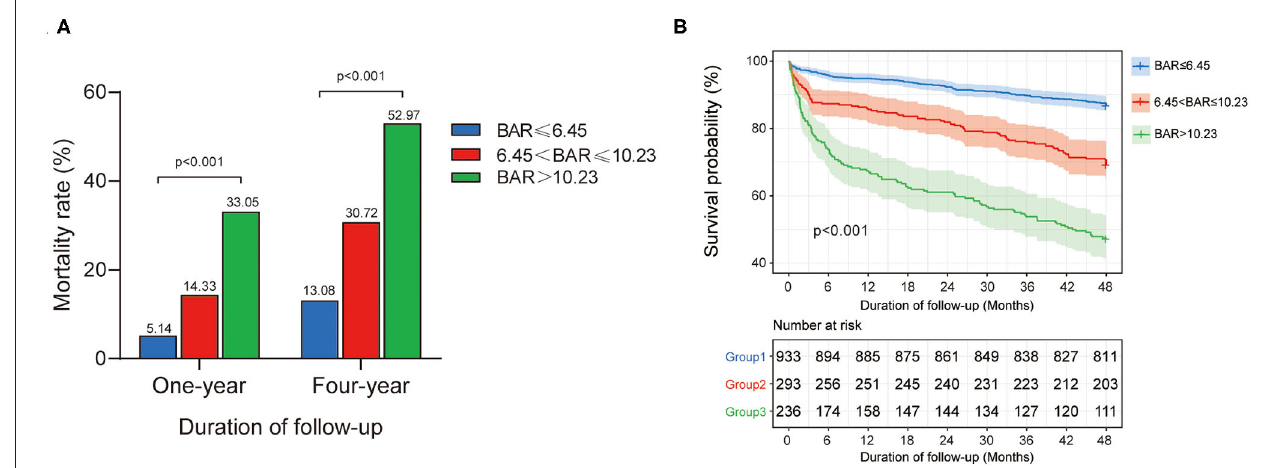
FIGURE 3 | Relationship between BAR and all-cause mortality in patients after CABG: (A) the mortality rate in each endpoint according to BAR levels, (B) The Kaplan–Meier survival curve of survival probability in patients with different BAR levels. P -value was calculated by log-rank test and indicated in the plot. BAR, blood urea nitrogen-to-albumin ratio; CABG, coronary artery bypass grafting.